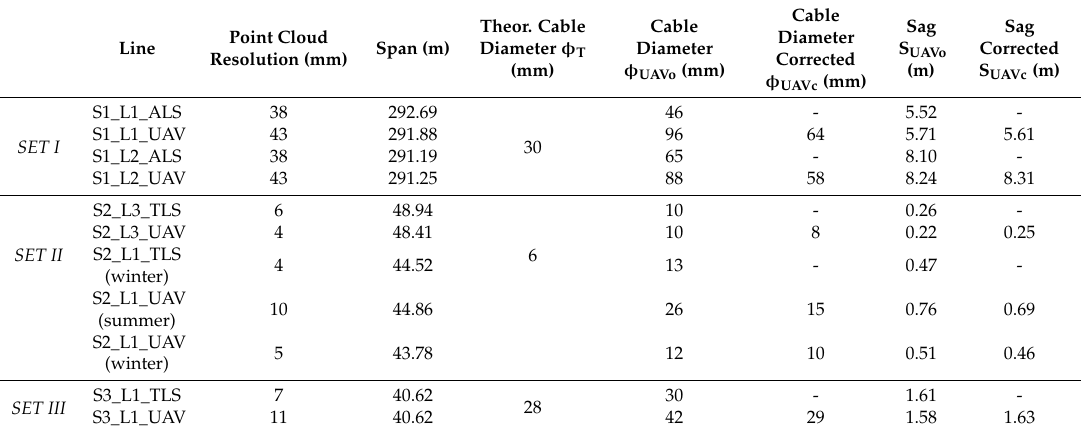
Table 5. Parameters of selected lines before and after